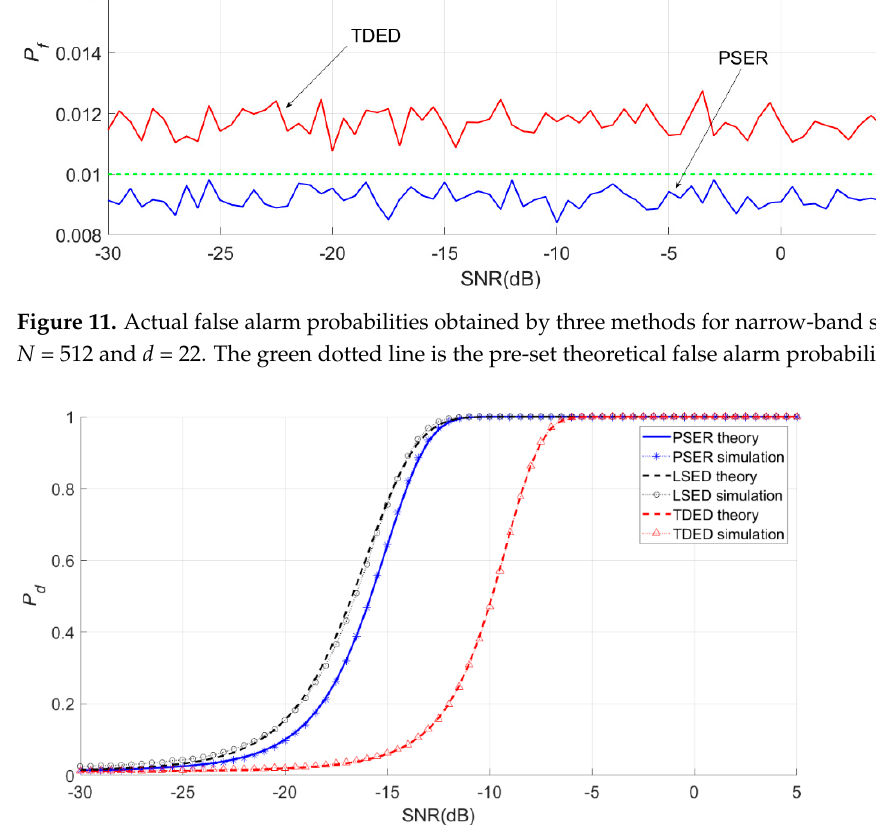
The average false alarm probability of the PSER was 0.0091, that of LSED was 0.0181, and that of the time-domain energy method was 0.0117. Therefore, as shown in Figure 11,